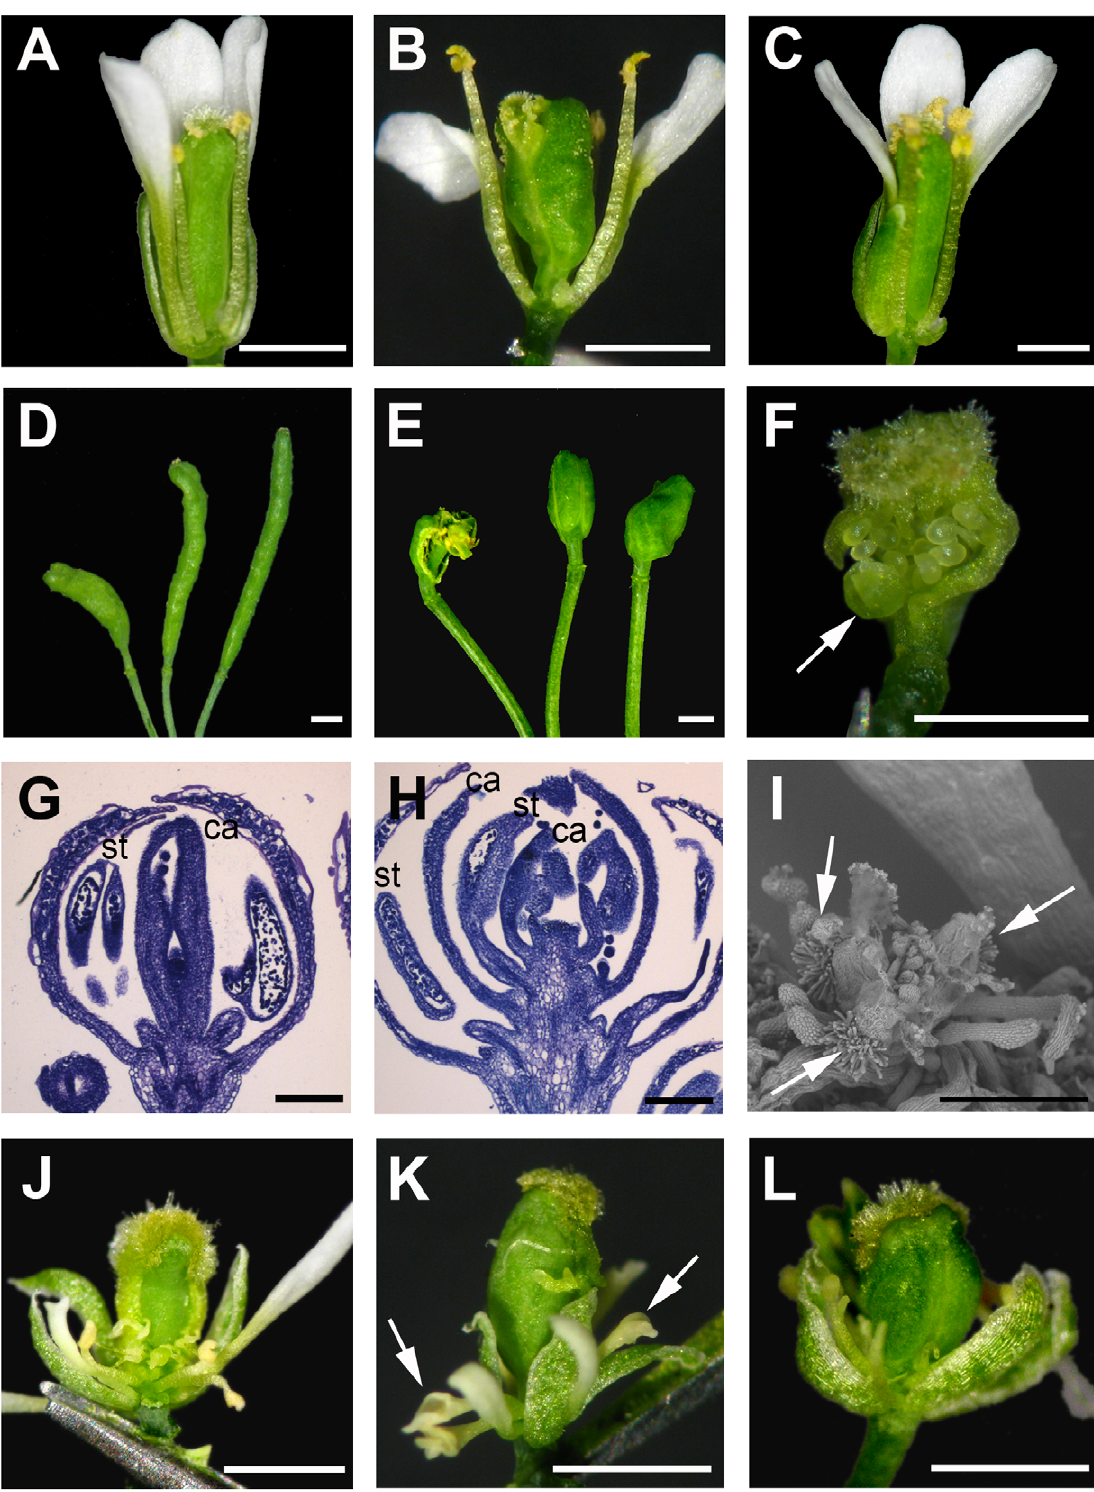
Figure 2. AGO10 and AGO1 promote floral determinacy. (A) An ag-10 flower; most ag-10 flowers were similar to wild-type ones. (B) An ag-10 ago10-13 flower; the gynoecia of ag-10 ago10-13 flowers were bulged and contained ectopic floral organs internally. (C) A flower of ag-10 ago10-13 pAGO10::AGO10-FLAG showing that AGO10 rescued the floral determinacy defects of ag-10 ago10-13 . (D) Representative siliques from ag-10 plants. Most were similar to wild-type siliques, while some were constricted on one side but still long and thin. Bulged siliques with internal floral organs (represented by the one on the left) were observed at a low frequency (usually 1-2 per plant). (E) Siliques from ag-10 ago10-13 plants. 100% of the siliques on an ag-10 ago10-13 plant were bulged. Occasionally, the primary carpels that make up a silique were not properly fused, revealing the internal organs. (F) An ago10-13 ago1-11/ + gynoecium with internal floral organs (arrow) bursting out of the gynoecium. (G, H) Longitudinal sections